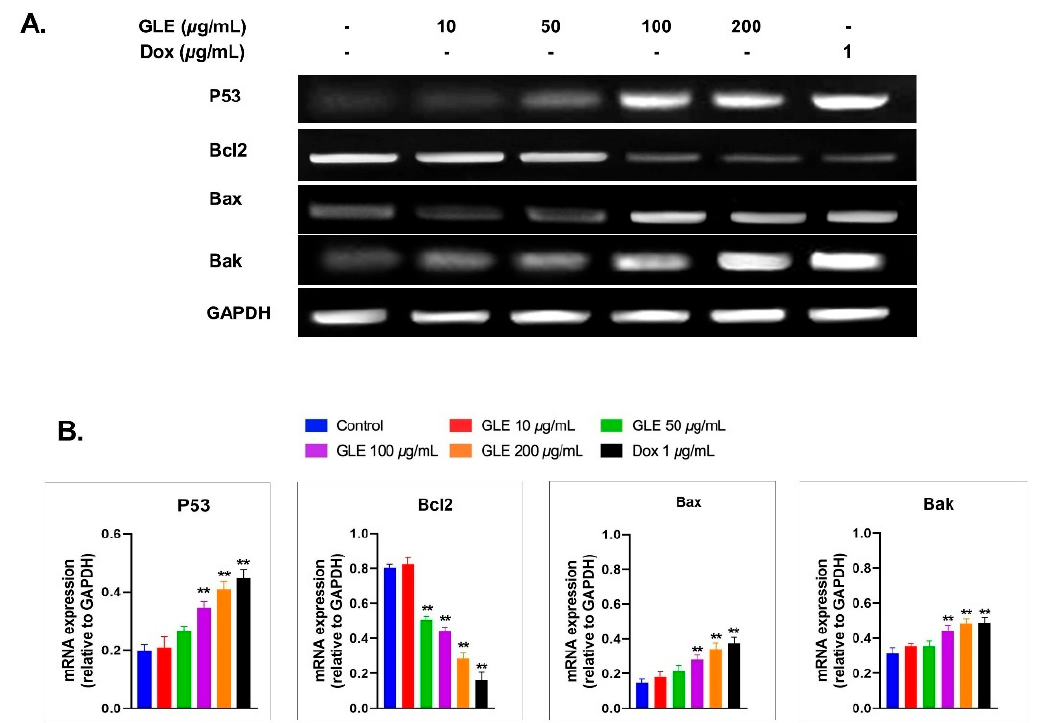
Figure 5. ( A ) Amplification of the apoptosis-related genes p53 , Bax , Bak , and Bcl2 . ( B ) Analyses of gene expression based on mRNA expression relative to the housekeeping gene GAPDH. ** indicates highly significant difference compared to control ( p < 0.01).